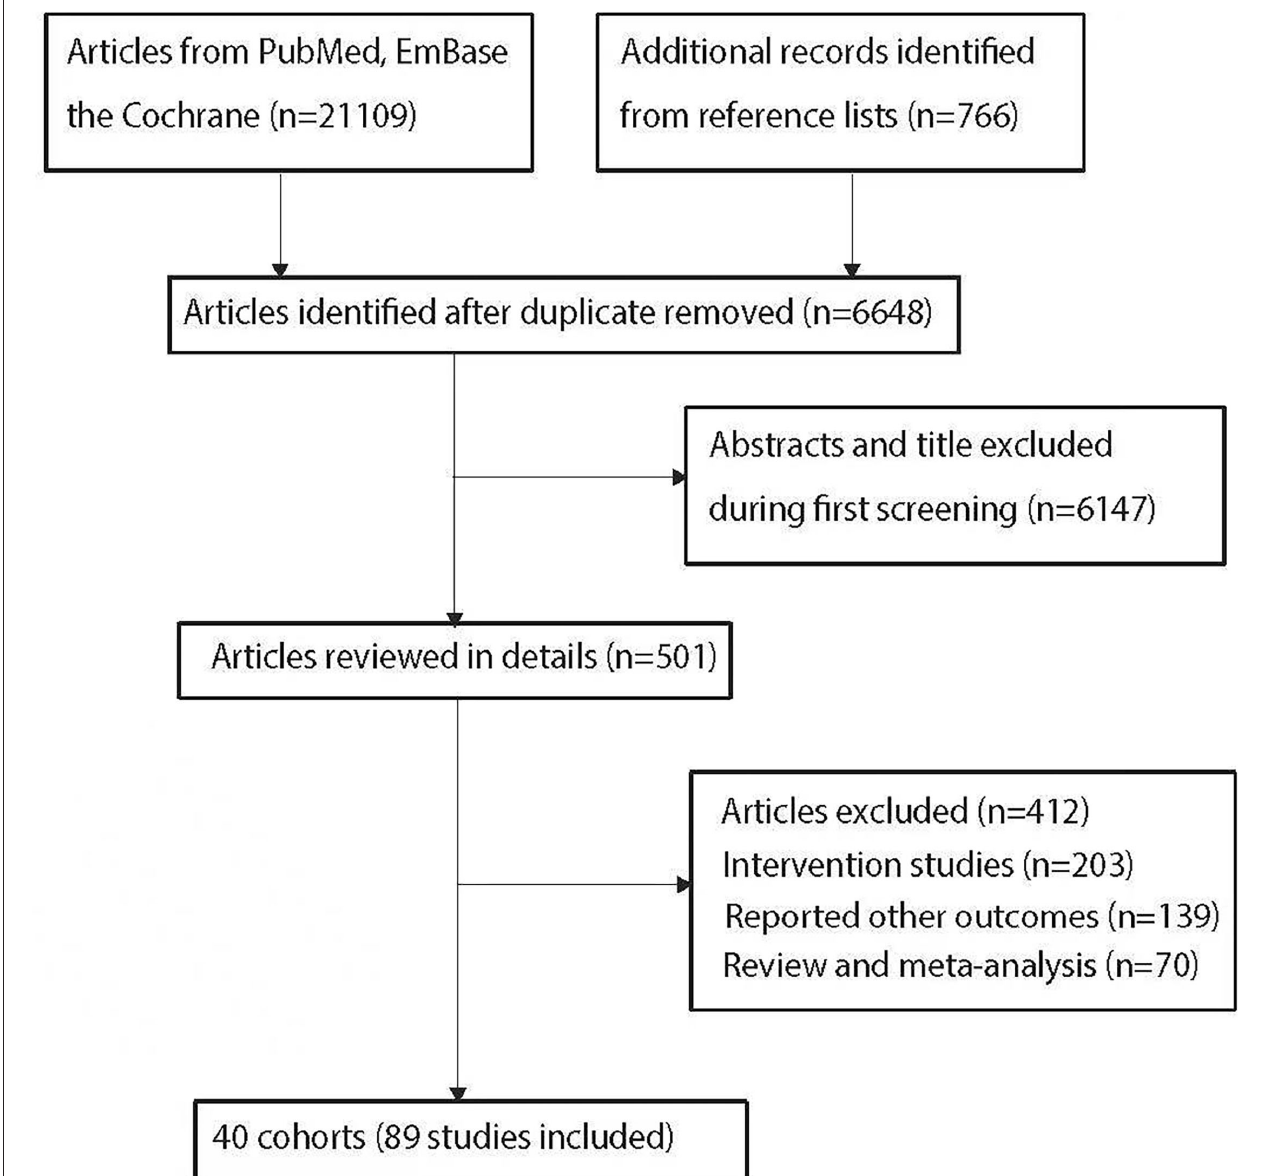
FIGURE 1 | The PRISMA flowchart for literature search and study